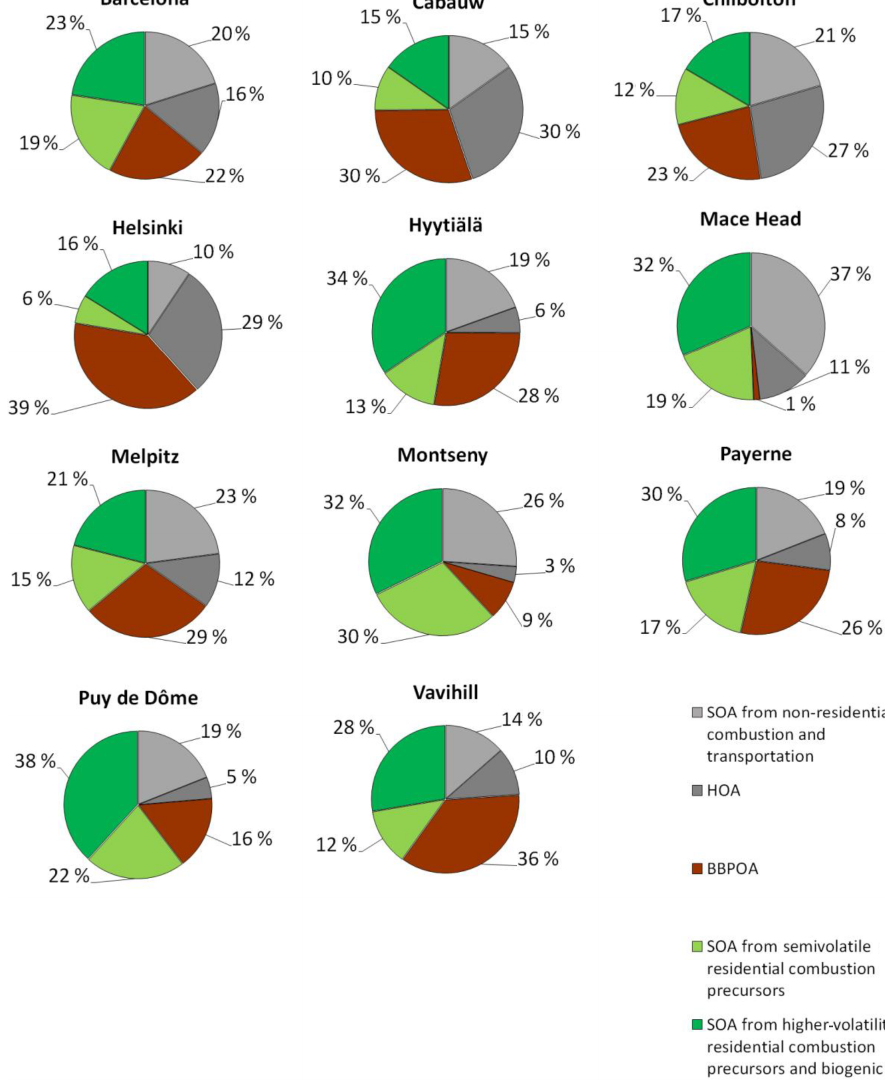
Data availability. The numerical simulations were performed us- ing the CAMx model, which is available from